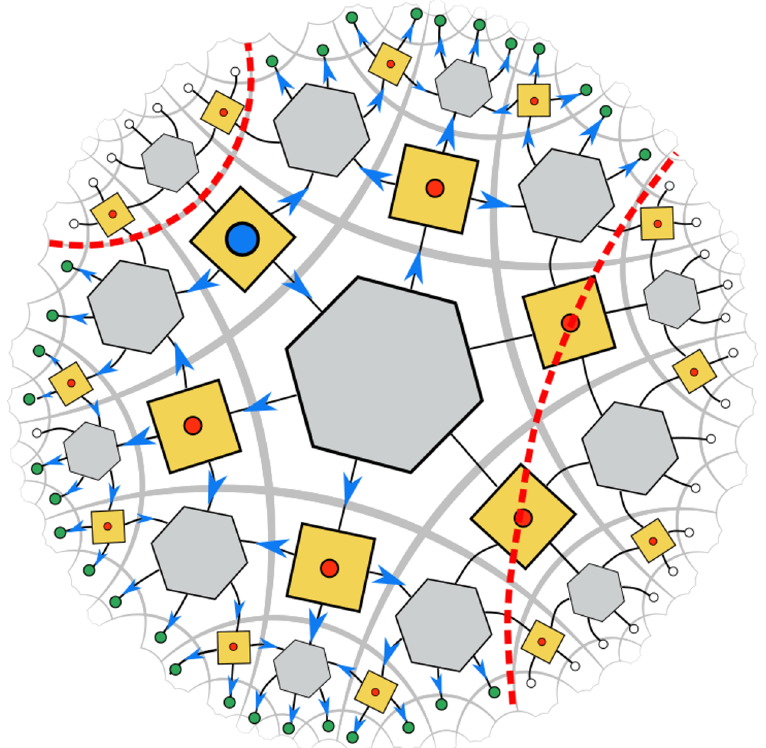
Figure 19. Representation of the same logical operator, but support over two disjoint boundary